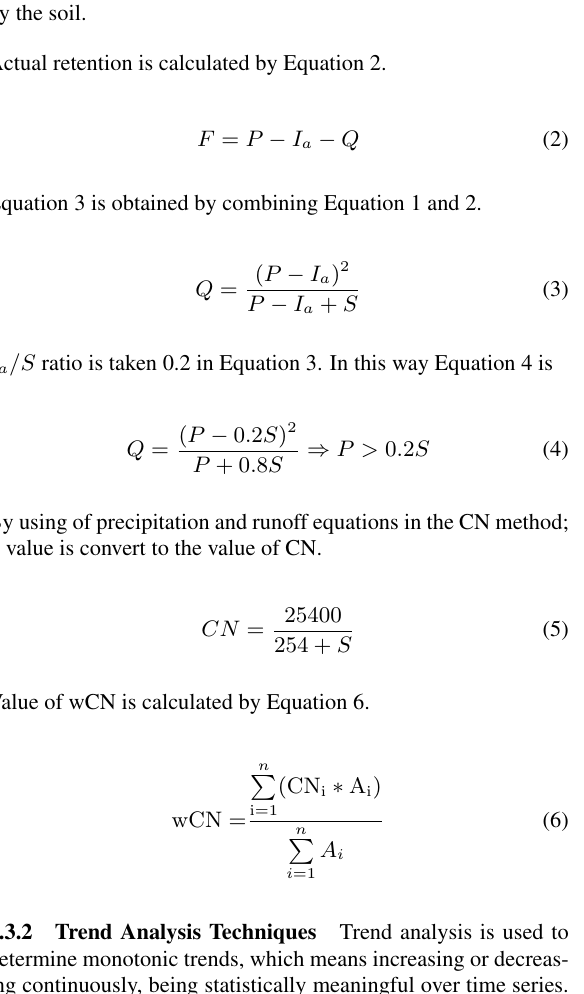
Table 1. Estimated curve number values of